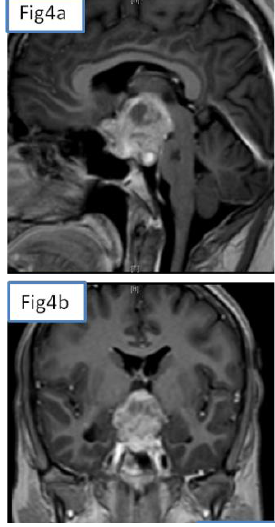
Figure 4a, b: T1W sagittal and coronal contrast MRI images showing a giant pituitary adenoma in 2014 but with a reduction in size 42 x 41 x 30 mm (Transverse x Coronary x Transverse) 1 year after radiotherapy, when compared to the previous MRI done in